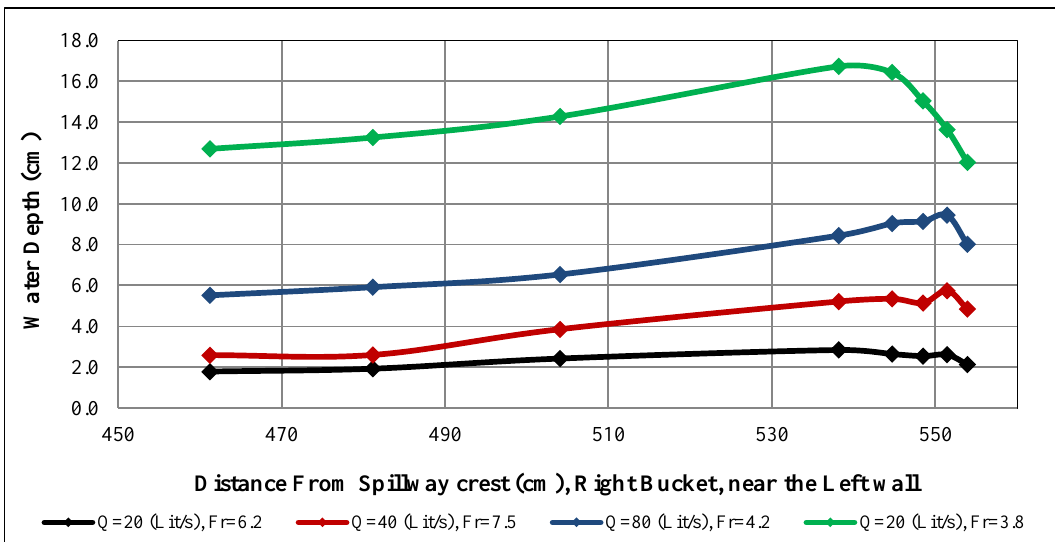
Figure 9. Variation of dynamic pressure on the left bucket near the left wall